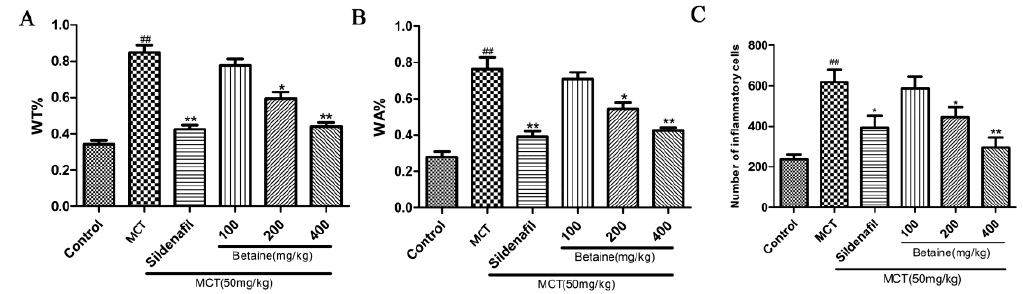
Figure 3. Effects of betaine on ( A ) the ratio of vascular wall thickness, ( B ) the ratio of vascular wall area and ( C ) number of inflammatory cells. Data are expressed as mean ± standard error of the mean ( n = 6). ## p < 0.01 vs. control group, * p < 0.05, ** p < 0.01 vs. MCT group. MCT: MCT-induced group, WT%: ratio of vascular wall thickness = 100% × (outer diameter of the pulmonary arterioles − inner diameter of the pulmonary arterioles)/(outer diameter of the pulmonary arterioles); WA%: ratio of vascular wall area = 100% × (transection area of the walls of pulmonary arterioles)/(cross-sectional area of pulmonary arterioles).